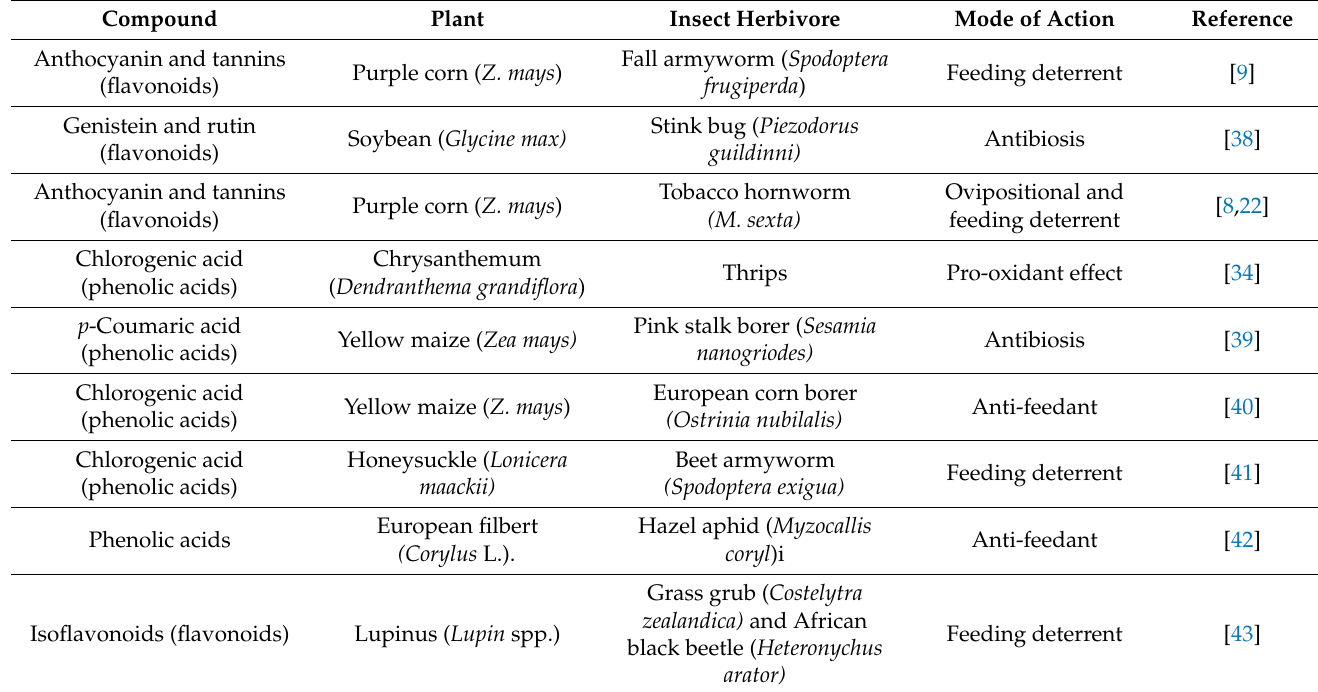
Table 1. Major polyphenolic compounds present in plants mediating insect-plant interactions. These compounds are widely distributed in different plant parts, defending plants from insect herbivores and in some cases, increasing the survival of insect herbivores through multiple modes of